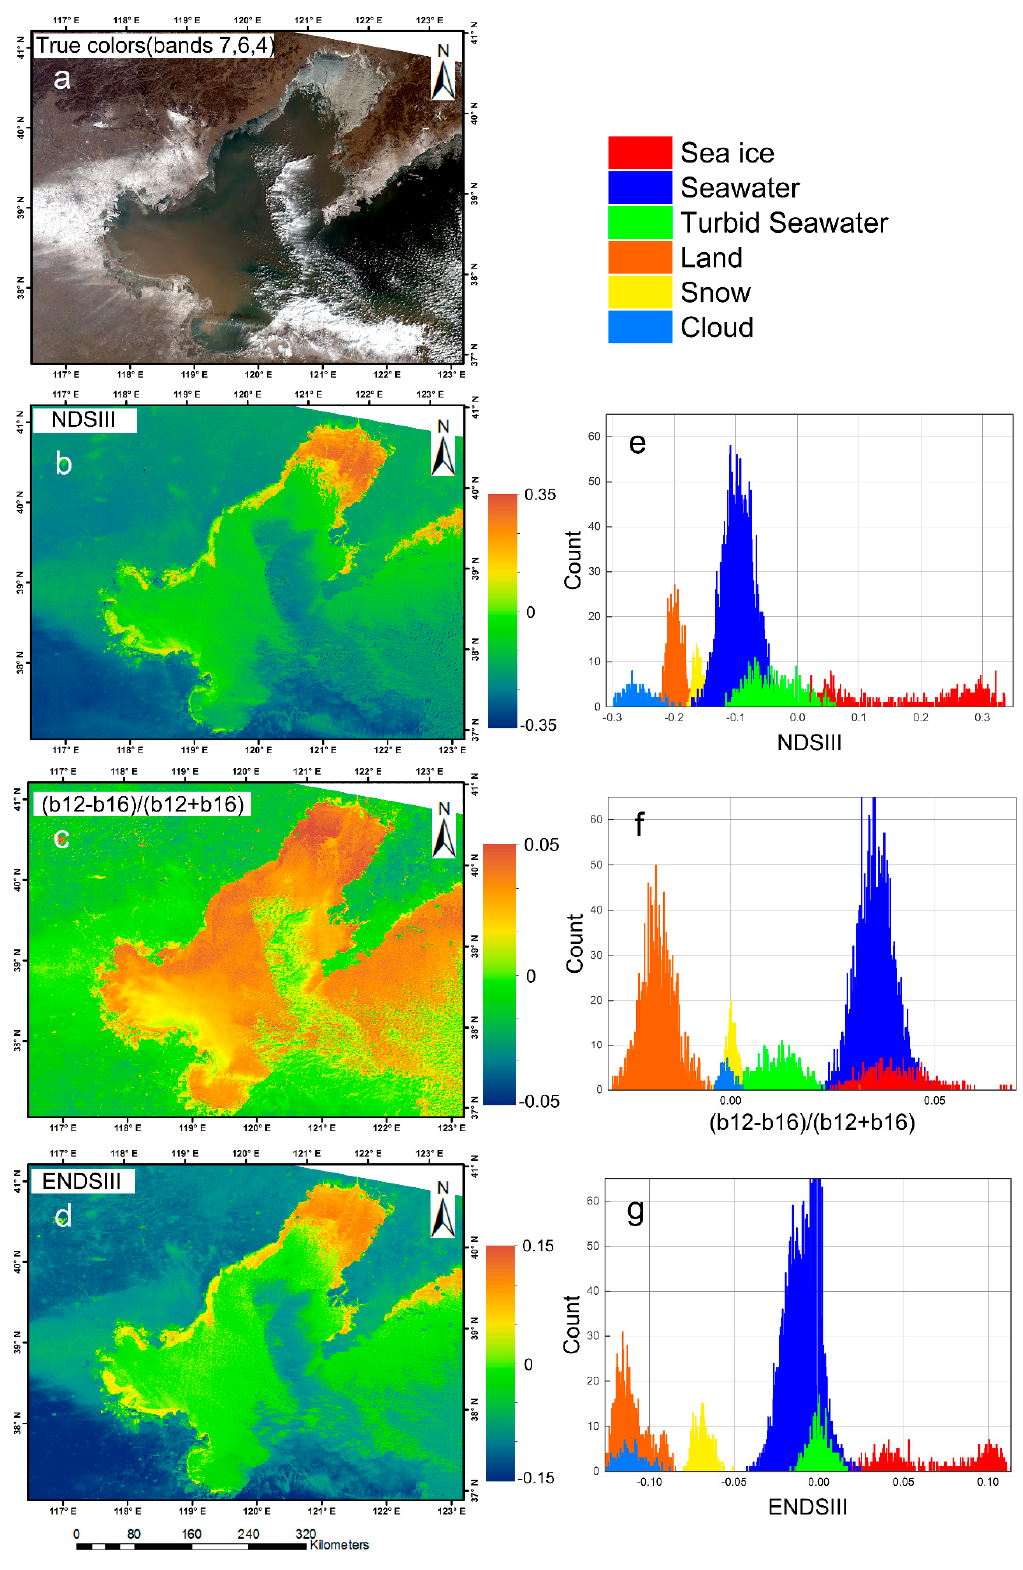
Figure 5. An example of true-color ( a ), NDSIII OLCI ( b ), (b12 − b16) / (b12 + b16) ( c ), and ENDSIII OLCI ( d ) feature extraction from OLCI imagery on 24 January 2018. A statistical histogram of the main types of surface cover (sea ice, seawater, turbid seawater, land, snow, and cloud) in each image is displayed alongside the corresponding image ( e – g